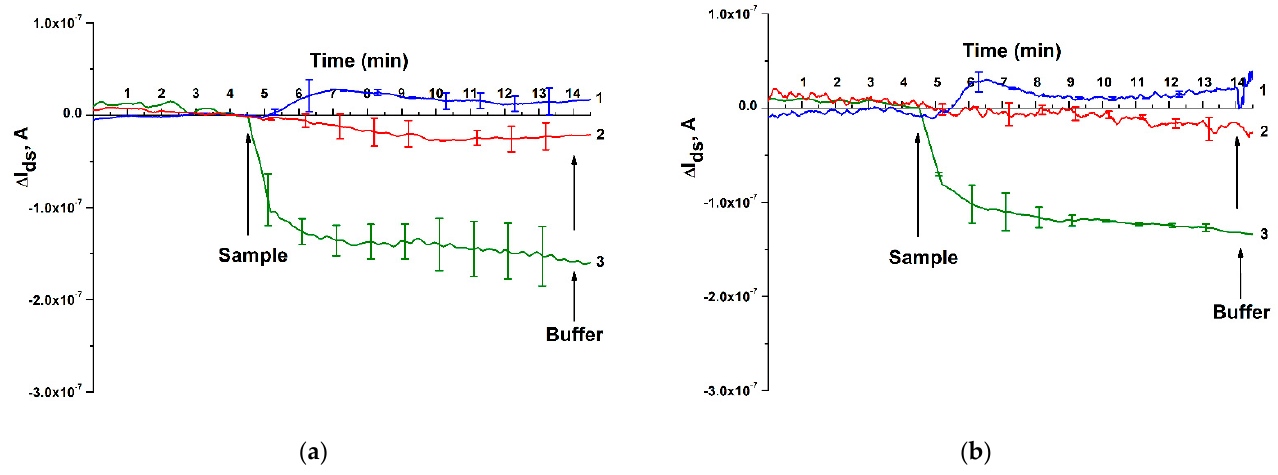
Figure 7. Detection of miRNA isolated from blood plasma using NRBS. ( a ) Results obtained on the first day of the study. (b ) Results obtained on the second day of the study. Legend: curve 1—control sample of miRNA isolated from blood plasma of a conditionally healthy patient diagnosed with urolithiasis (non-oncological); curve 2—control sample of miRNA isolated from the blood plasma of a patient with adenocarcinoma of the prostate; curve 3—miRNA-17-3p sample isolated from blood plasma of a patient diagnosed with colorectal cancer. Number of technical replicates is n = 3. Arrows indicate the addition of miRNA solutions and 1 mM potassium phosphate wash buffer.